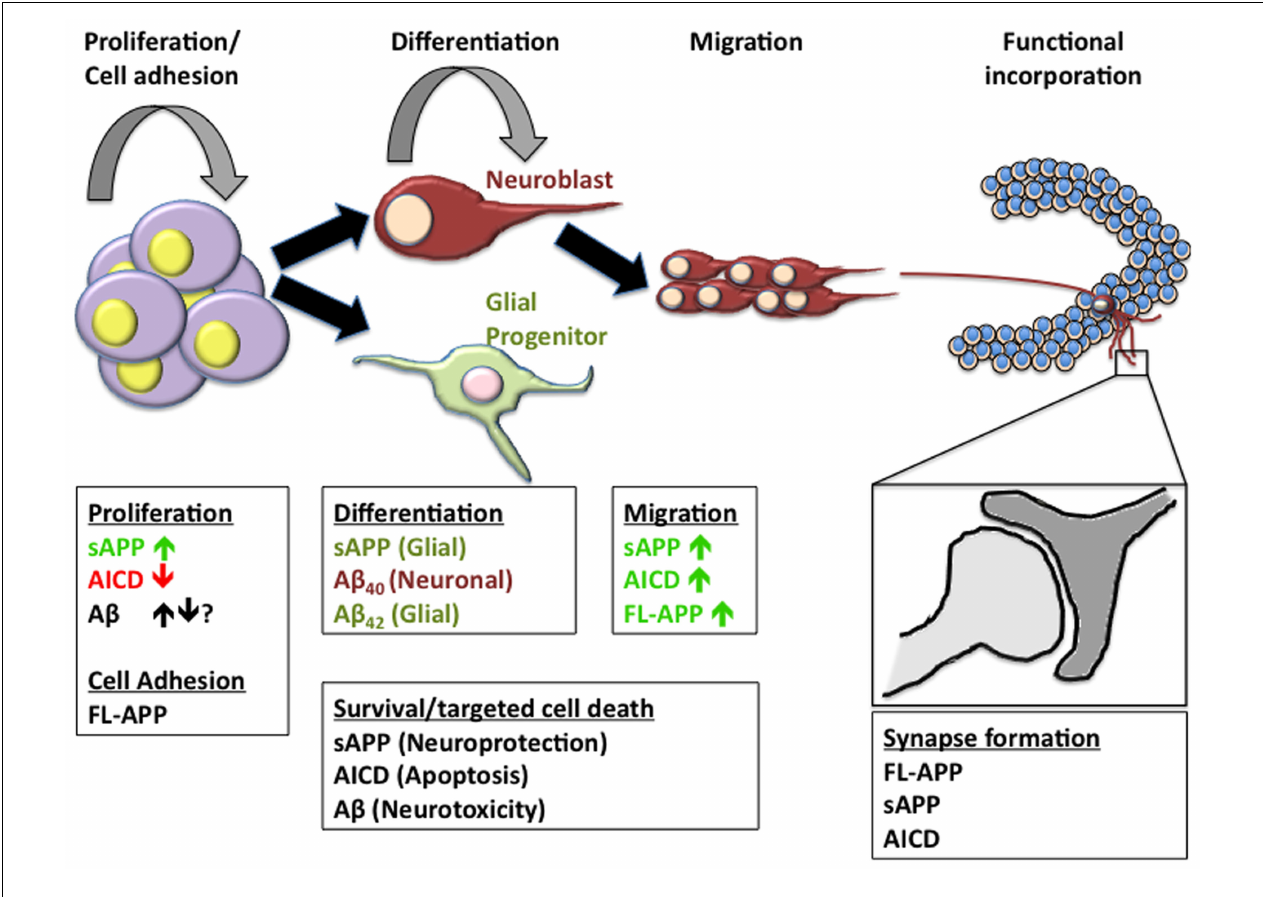
existing neural networks. Many of the metabolites of APP have been implicated in one or more of these processes. In order to fully understand the impact of APP metabolism on neurogenic processes, we must first unravel the individual functions of each of the metabolites in order to better realize the implications of alterations in the cleavage pattern of